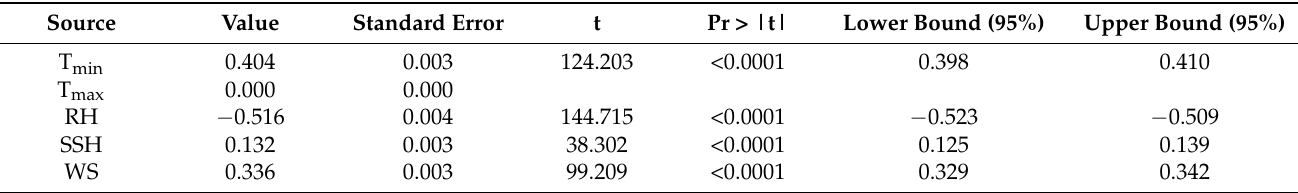
Table 5. The regression analysis for identifying the most effective parameters for evaporation estimation at the New Delhi station.